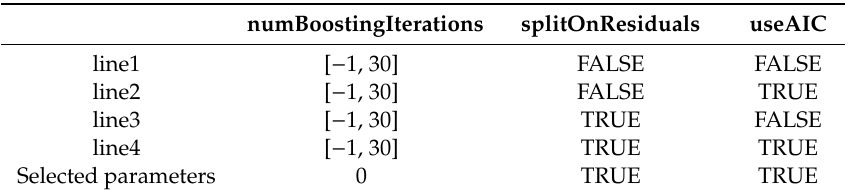
Table 2. Relevant parameters of the LMT model.